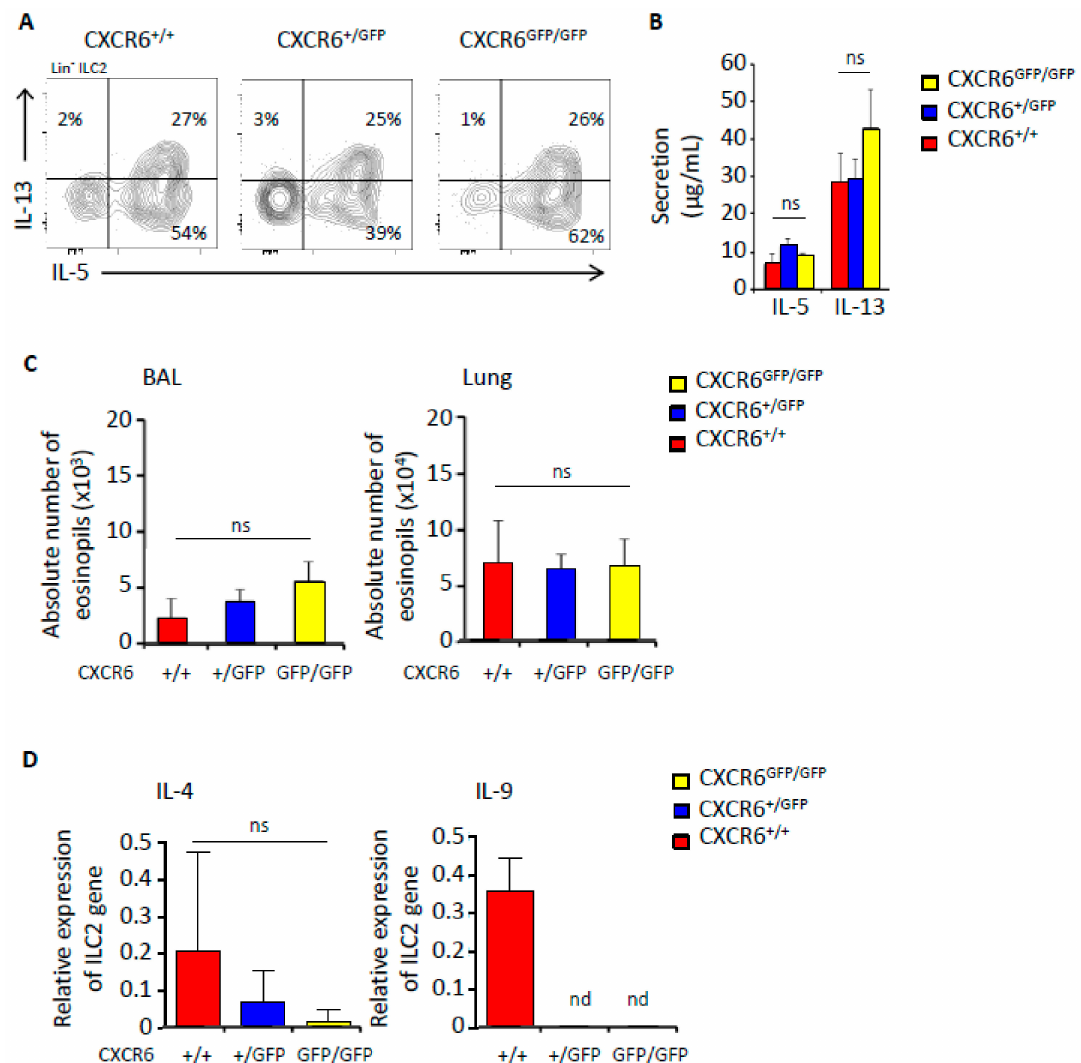
Figure 4. Maintenance of type 2 secretion by ILC2 in CXCR6 deficient mice after papain induction. ( A ) Flow cytometry analysis of CD45 + Lin − (CD3, CD5, CD19, TCR β , TCR γδ , Gr1, Ter119, CD8 α and F4 / 80) NKp46 − Sca1 + ICOS + lung cells from Rag − / − CXCR6 +/+ , Rag − / − CXCR6 +/ GFP and Rag − / − CXCR6 GFP / GFP mice. Di ff erent subsets are disigned in function of IL-5 and IL-13. ( +/+ = 5, +/ GFP = 13, GFP / GFP = 11) ( B ) Dosage by ELISA of IL-5 and IL-13 secretions from BAL of Rag − / − CXCR6 +/+ , Rag − / − CXCR6 +/ GFP and Rag − / − CXCR6 GFP / GFP mice. ( +/+ = 5, +/ GFP = 13, GFP / GFP = 11) ( C ) Absolute number of eosinophils (CD45 + Lin − SiglecF + CD11b + ) from Rag − / − CXCR6 +/+ , Rag − / − CXCR6 +/ GFP and Rag − / − CXCR6 GFP / GFP mice in BAL (left graph) and lung (right graph). ( +/+ = 5, +/ GFP = 13, GFP / GFP = 11) ( D ) 1000 ILC2 (Lin − CD45 + NK1.1 − ST2 + ) were sorted from Rag − / − CXCR6 +/+ , Rag − / − CXCR6 +/ GFP and Rag − / − CXCR6 GFP / GFP mice. After mRNA extraction, gene study was performed by real time RT-PCR. Relative expression of IL-4 and IL-9 genes (expression compared to Hprt